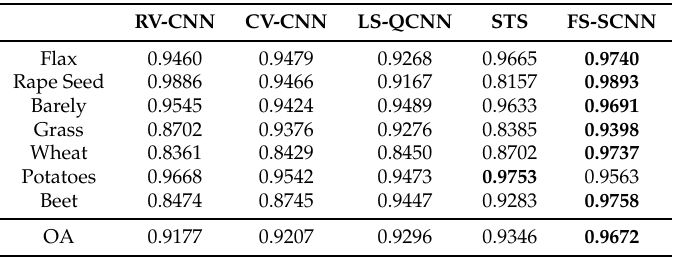
Table 3. Classification accuracy comparisons on